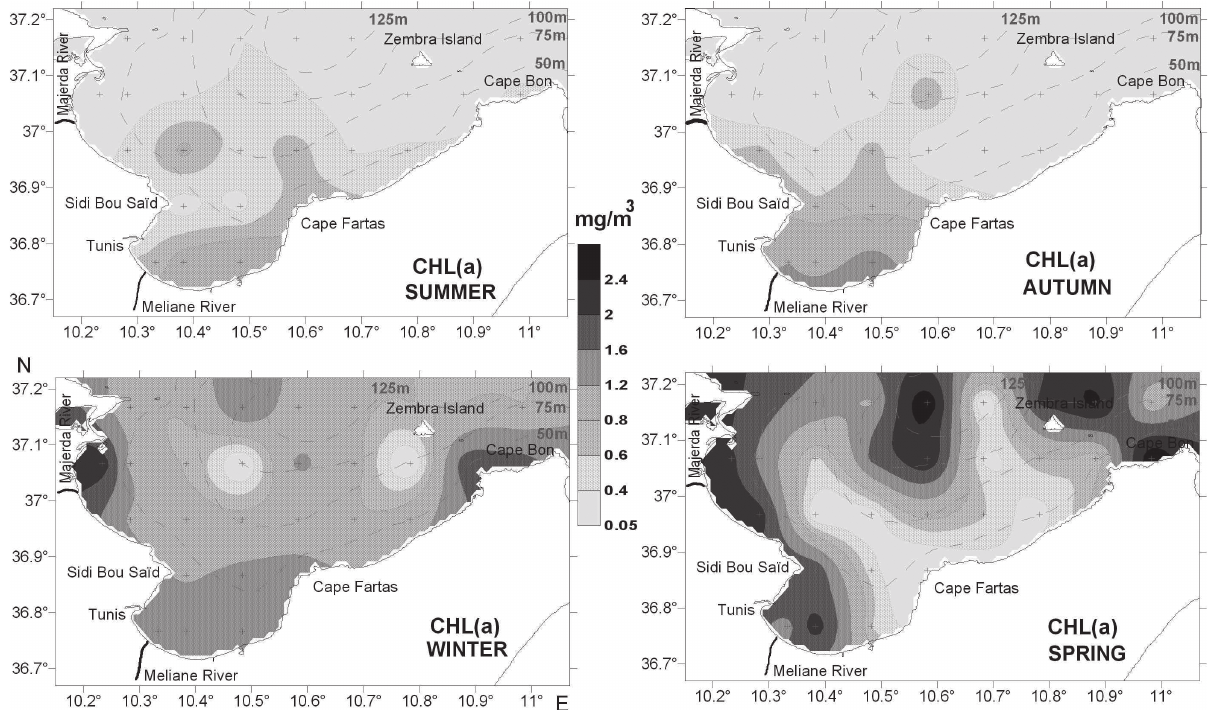
Fig. 5. – chlorophyll a distribution by